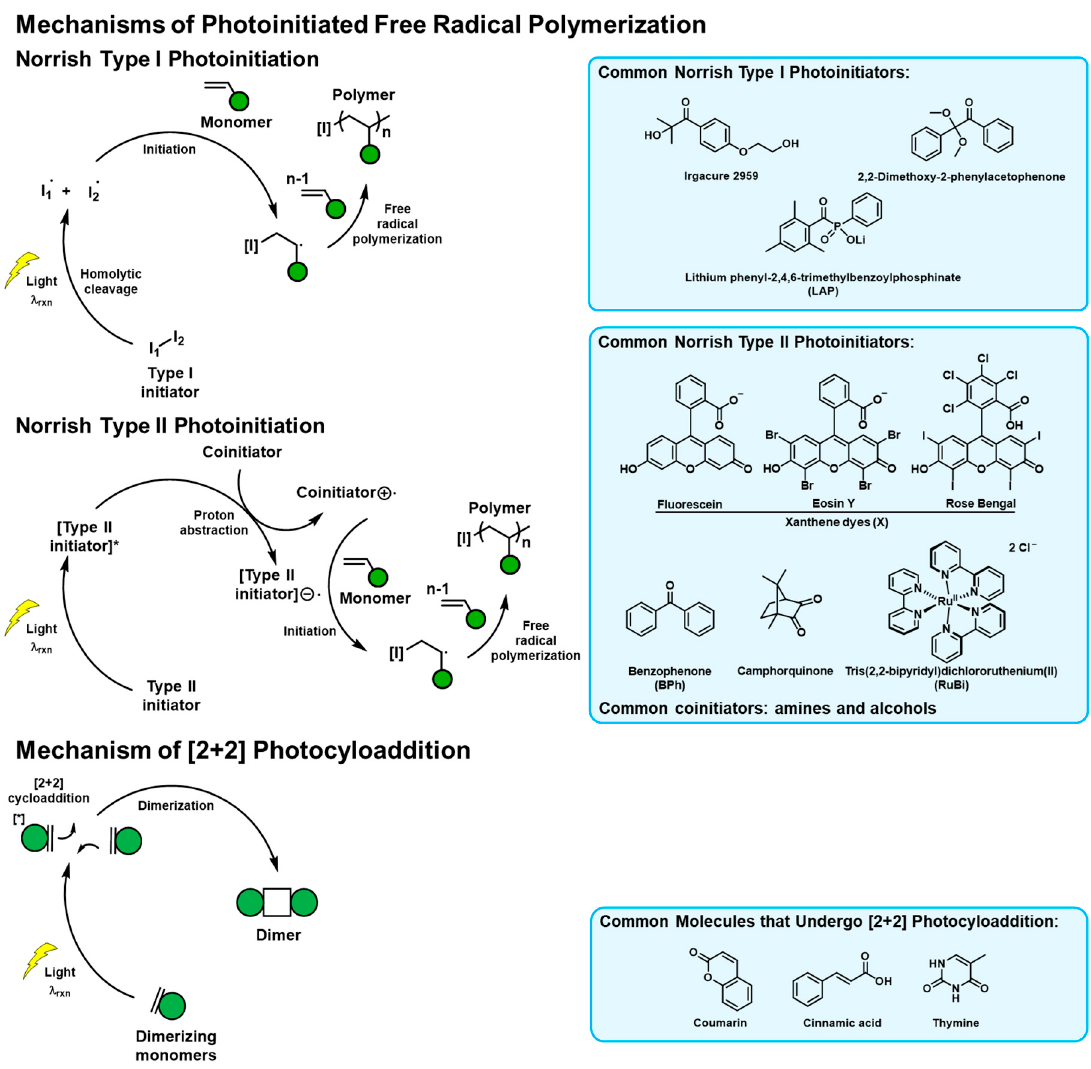
Figure 1. Mechanisms of the photoreactions popularly used in naturally derived tissue adhesive materials. The commonly used initiators and photoreactive molecules are listed.